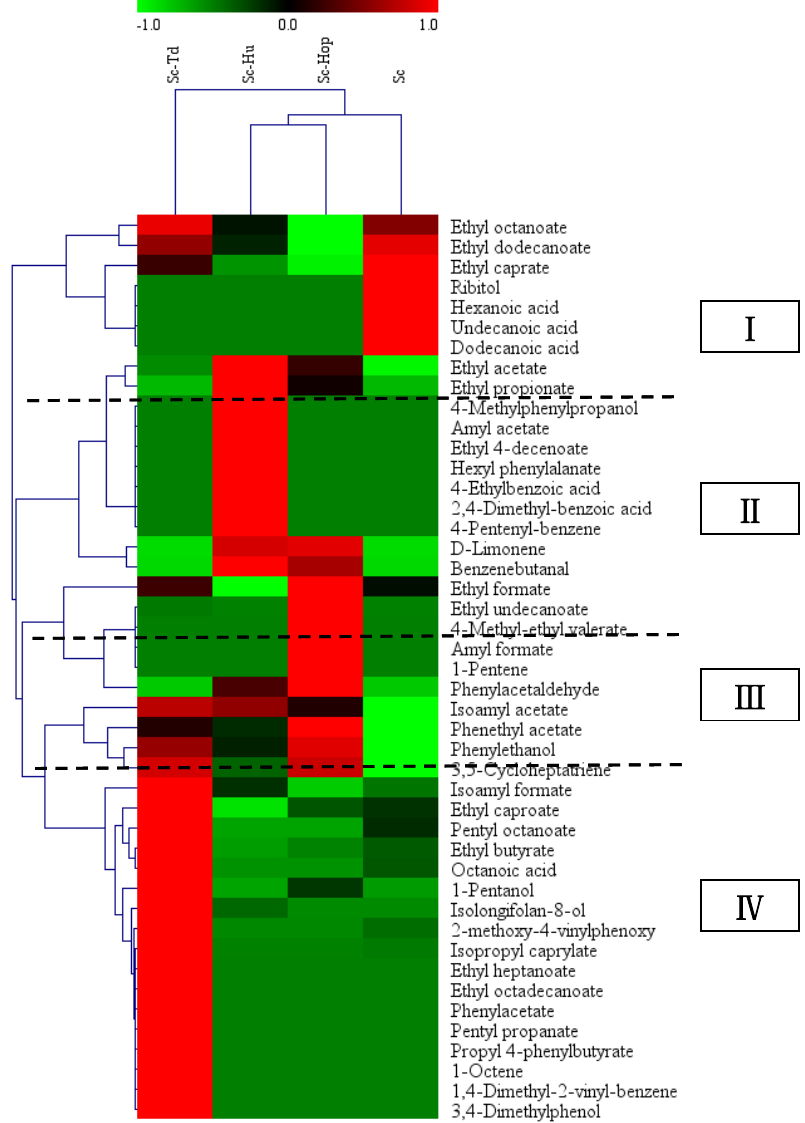
Figure 3. Hierarchical cluster analysis of volatile compounds in citrus wines. Normalization of all values for better visualization; Sc-Hu, S. cerevisiae / H. uvarum co-fermentation; Sc-Td, S. cerevisiae / T. delbrueckii co-fermentation; Sc-Hop, S. cerevisiae / H. opuntiae co-fermentation; Sc, S. cerevisiae fermentation.